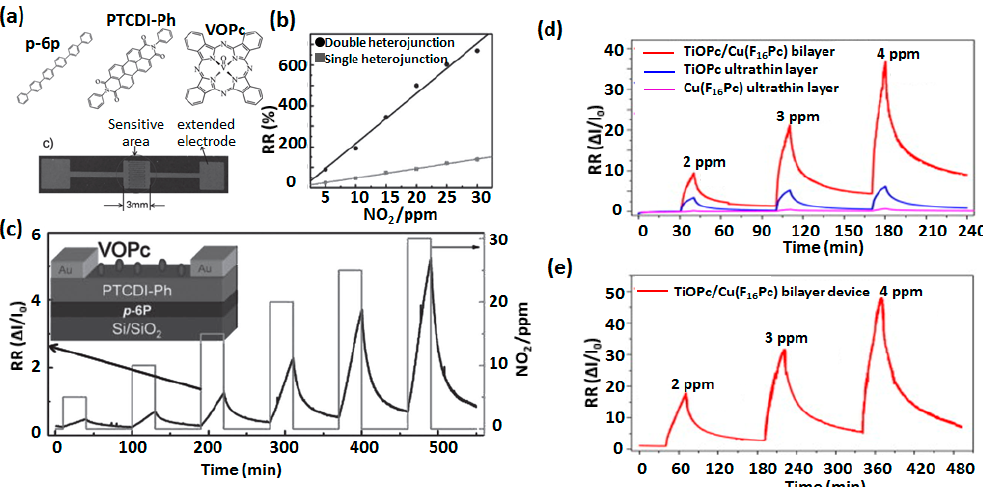
Figure 10. Structure of p-6P, PTCDI-Ph, VOPc and optical image of the device ( a ). Comparison of calibration curves (RR vs NO 2 concentration) of single (p-6P / PTCDI-Ph) and double (p-6P / PTCDI-Ph / VOPc) heterojunction OFET in NO 2 concentration range 5–30 ppm ( b ). Response curves of the double heterojunction OFET as a function of time at di ff erent alternate exposure of NO 2 in the range of 5–30 ppm. The configuration of the OFET device is shown in the inset of ( c ) (adapted from [44]) Comparison of response curves as a function of time for TiOPc, Cu(F 16 Pc) and TiOPc / Cu(F 16 Pc) bilayer based OFET device at three di ff erent NO 2 concentrations ( d ) and similar curves of the bilayer OFET at longer exposure and recovery time ( e ). (adapted from